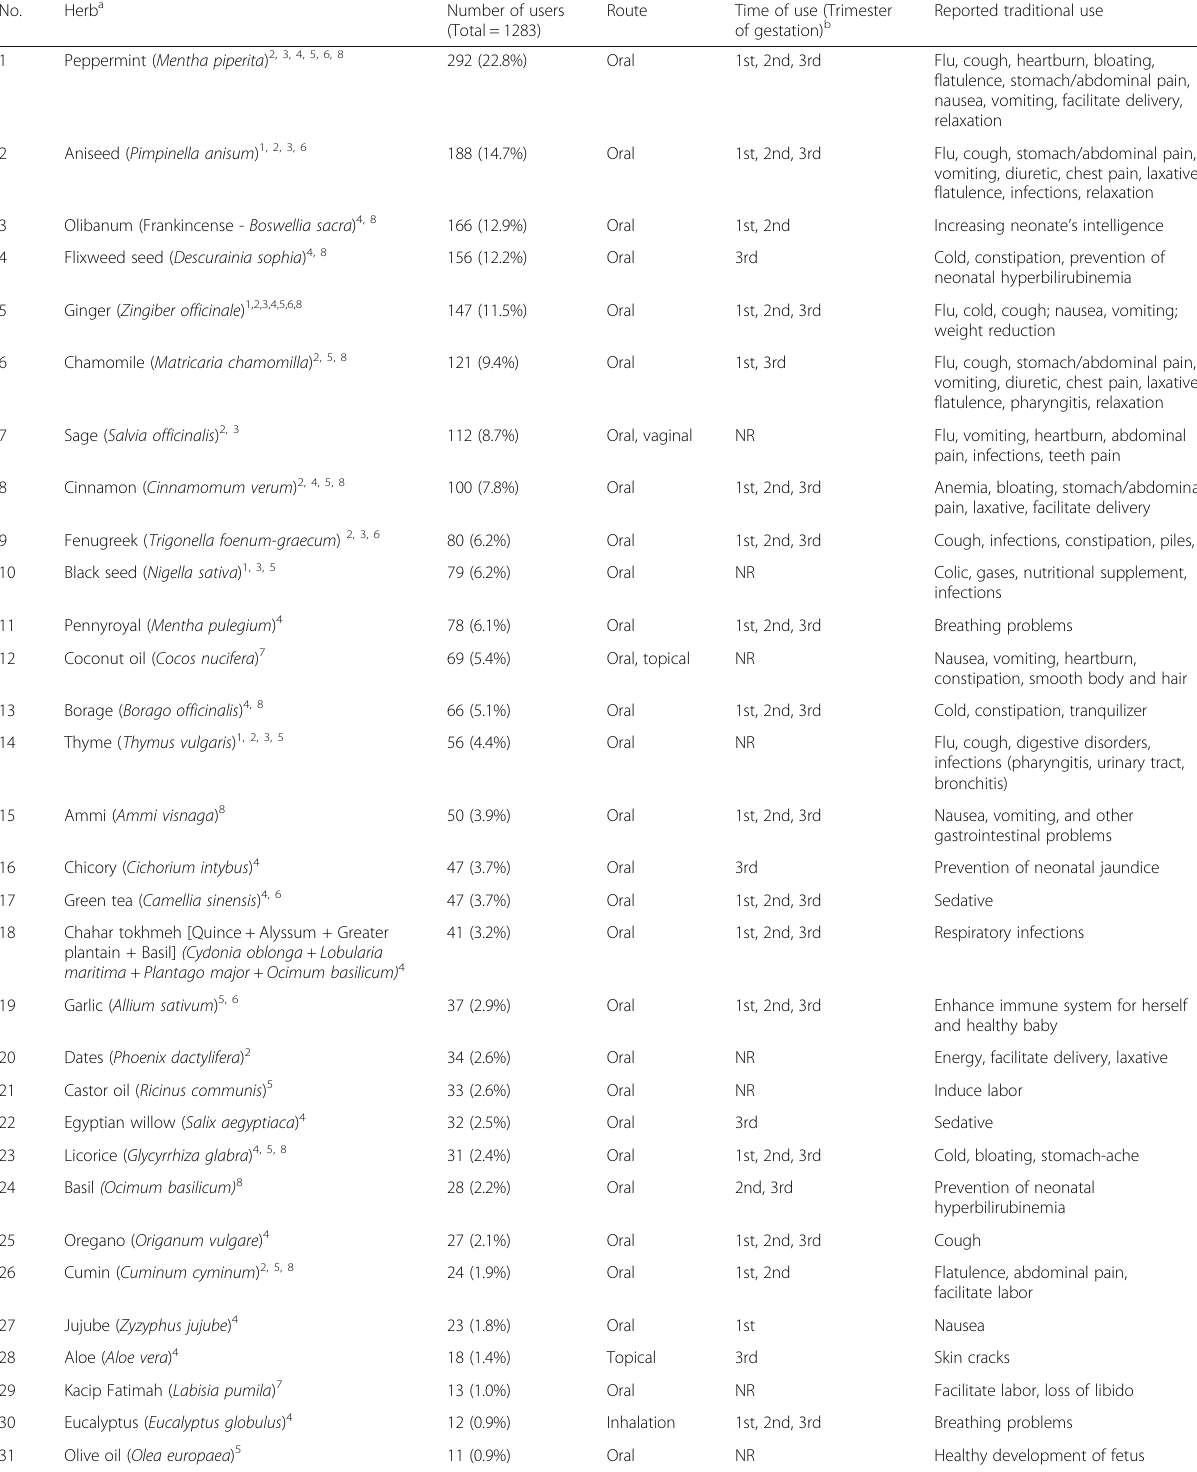
Table 4 The most frequently used herbs, route of administration and reported traditional indications during pregnancy No. Number of users